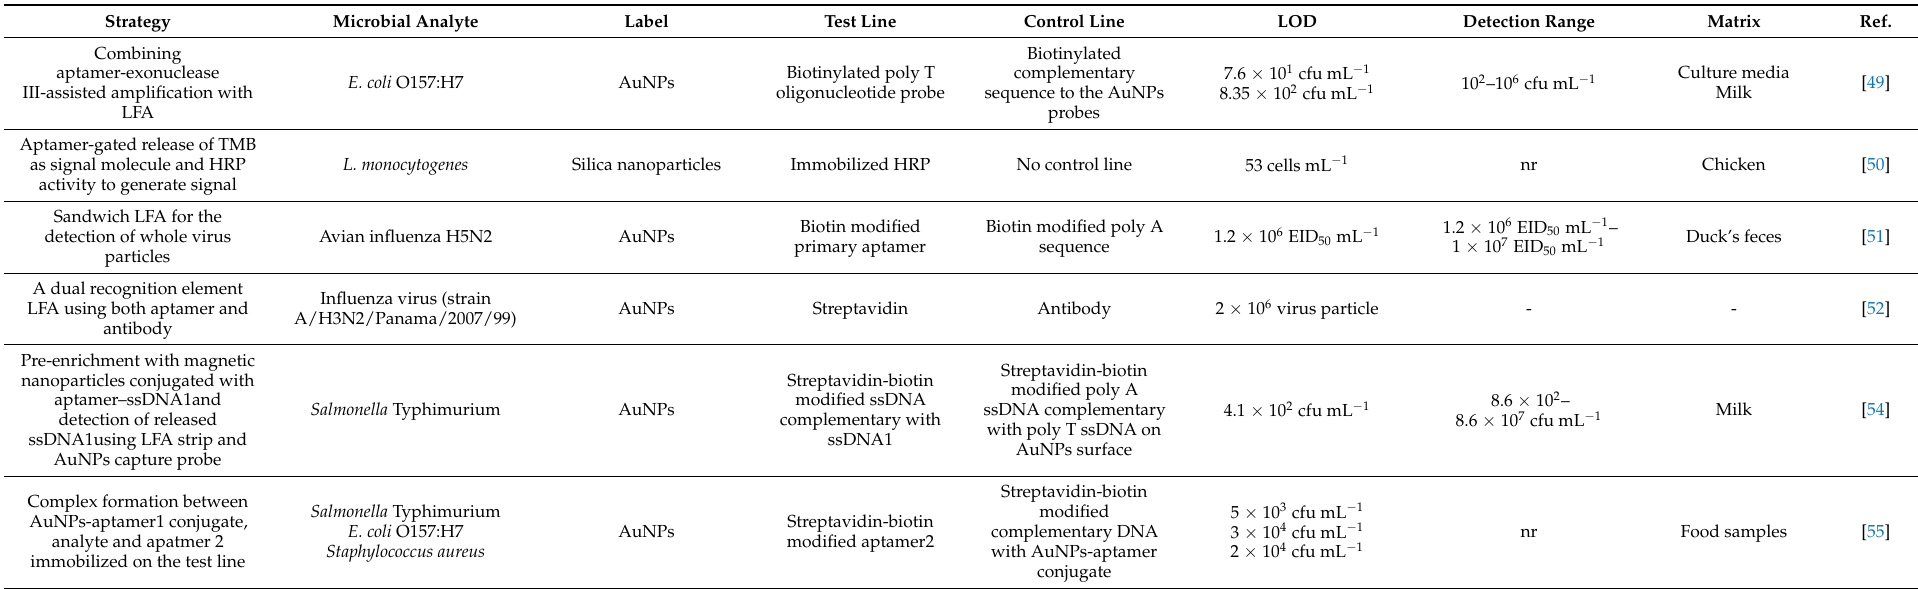
Table 2. Aptamer-based lateral flow assays for detection of microbial